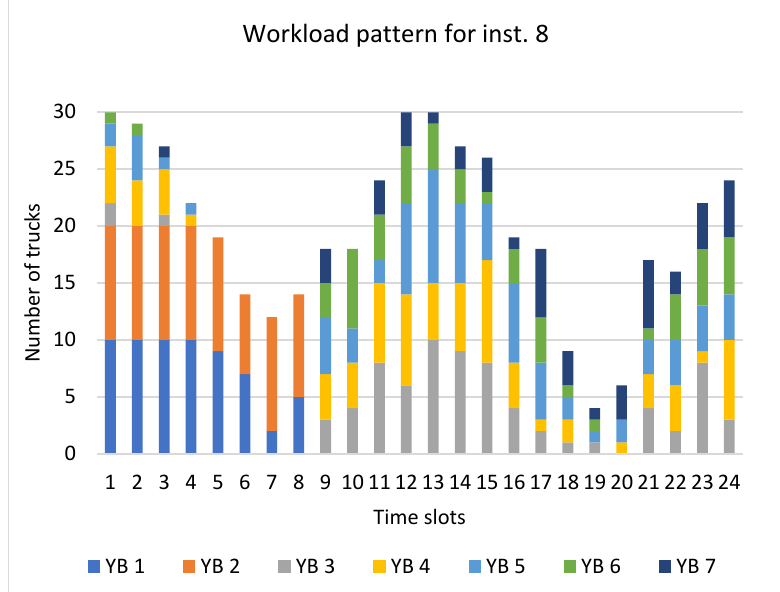
Figure 4. The workload distribution for instance 8.